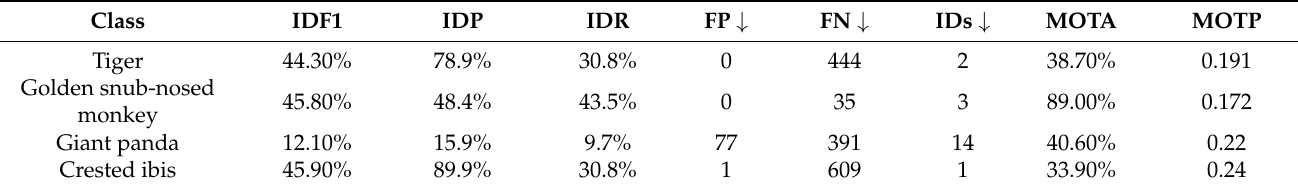
Table A4. Results of the same few-shot object detector in our model combined with V-IoU-tracker tracker on the MOT-EA